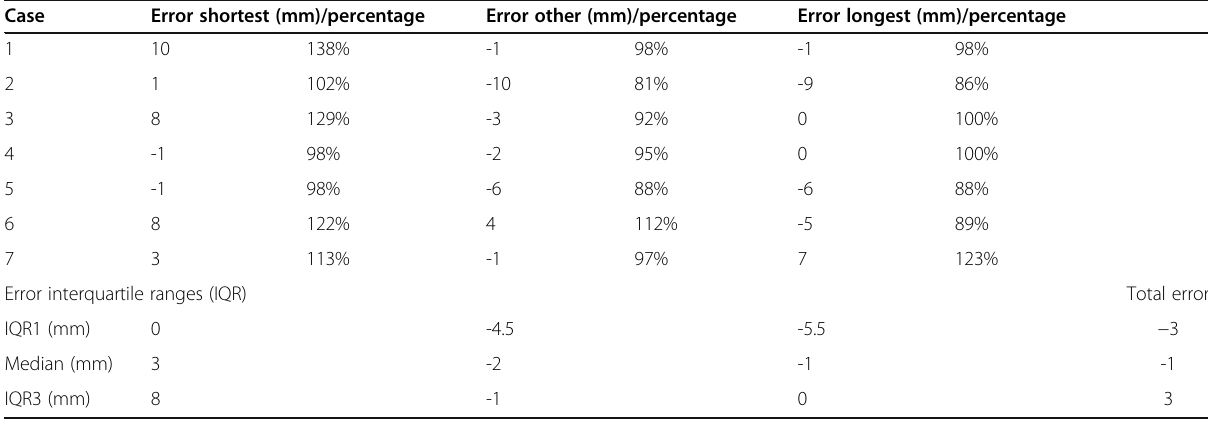
Table 3 Absolute (in mm) and relative (as percentage, deviating from 100%) errors, including the median and interquartile ranges (IQR) per measured direction, and the total error taking every measurement into